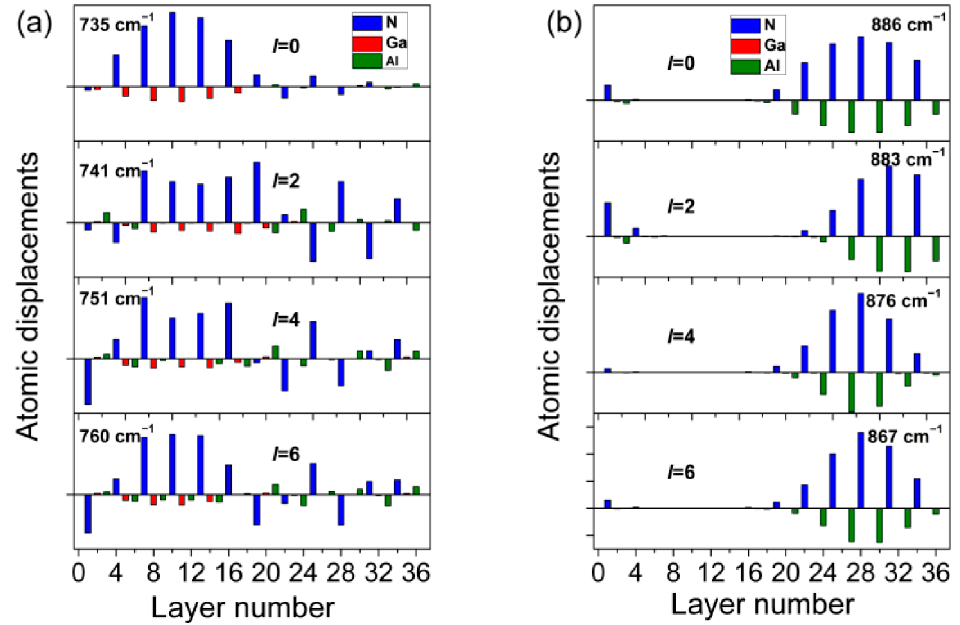
Figure 4. Atomic displacement patterns of A 1 (LO) GaN ( a ) and A 1 (LO) AlN ( b ) modes for (GaN) 6 /(AlN) 6 SL.